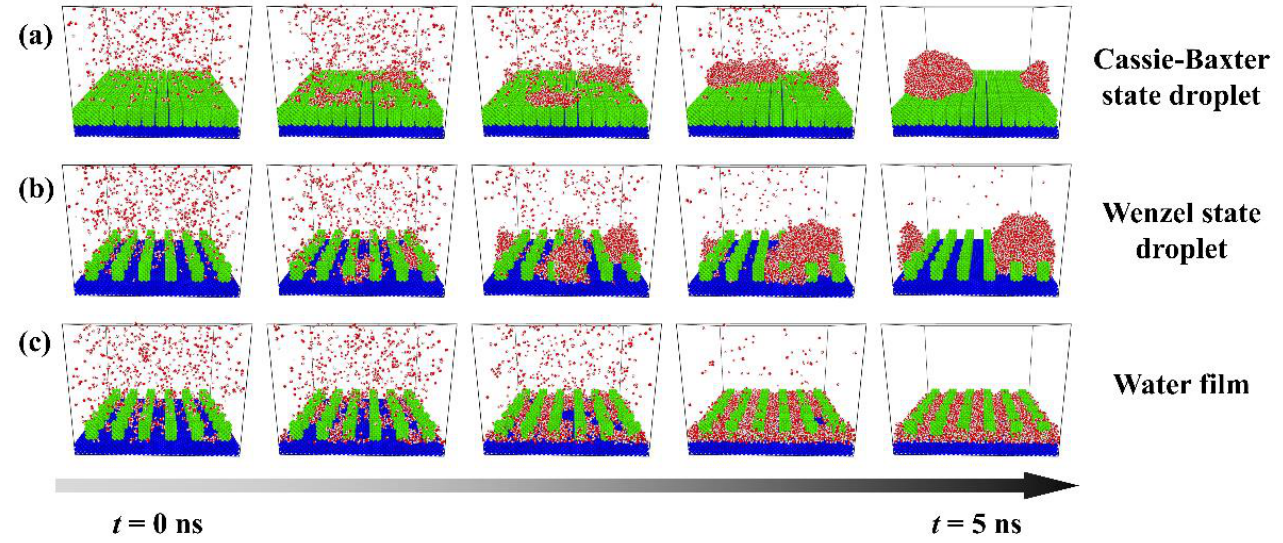
Figure 2. Condensation processes of three typical condensation modes on the nanopillar surface. ( a ) Cassie-Baxter DWC mode observed on the surface P 0.4 S 0.4 D 1 ; ( b ) Wenzel DWC mode observed on the surface P 0.25 S 0.25 D 3 ; ( c ) FWC mode observed on the surface P 0.4 S 0.4 D 3 .